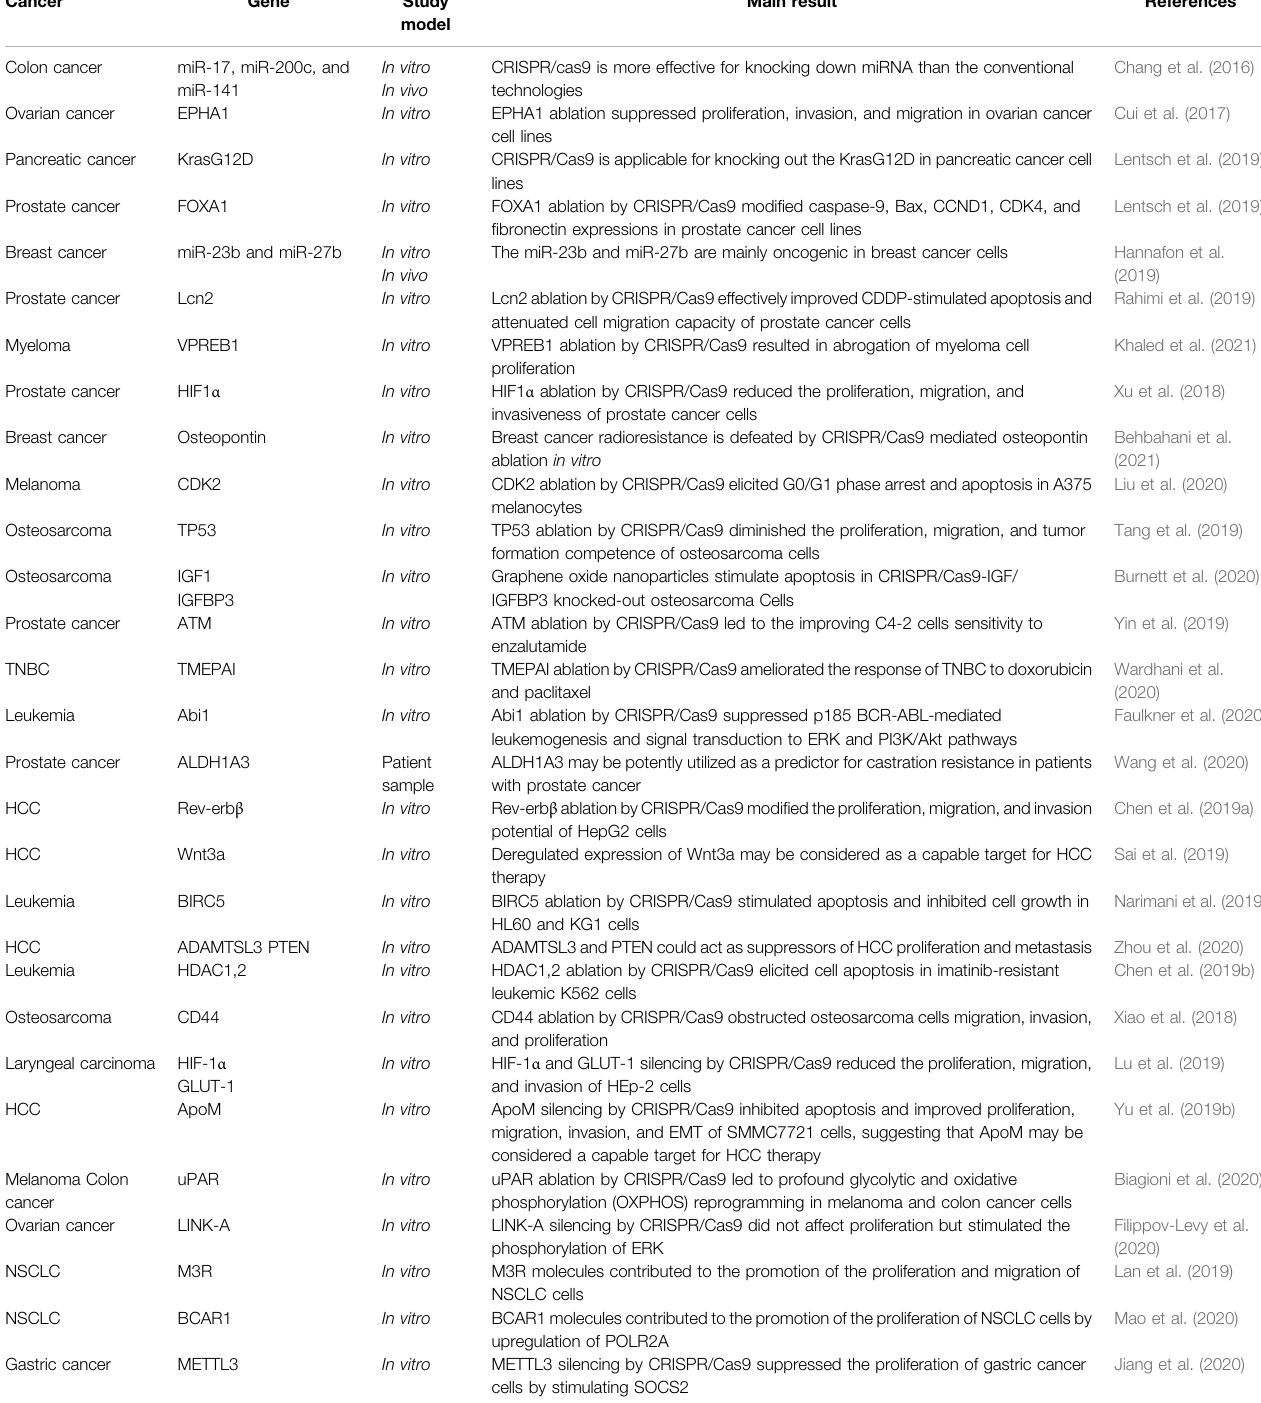
TABLE 1 | Overview of the application of CRISPR/Cas9 in cancer